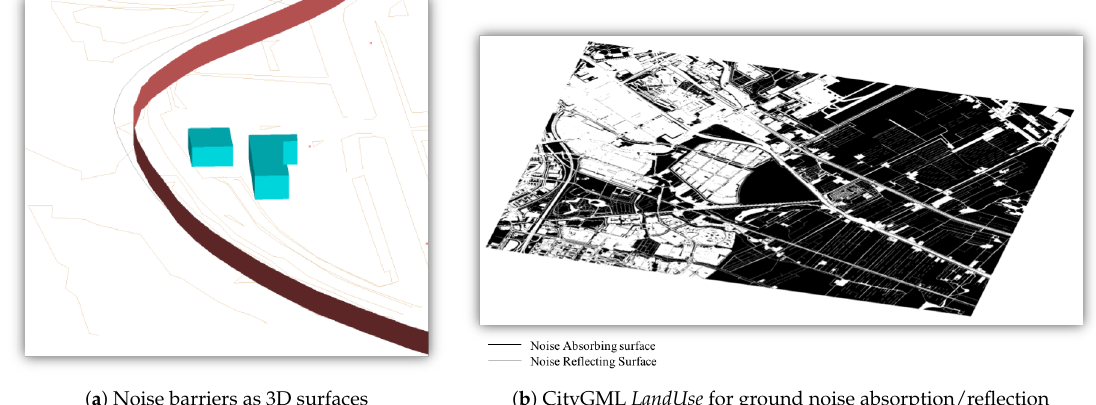
Figure 11. Noise barriers and ground types in the generated 3D city